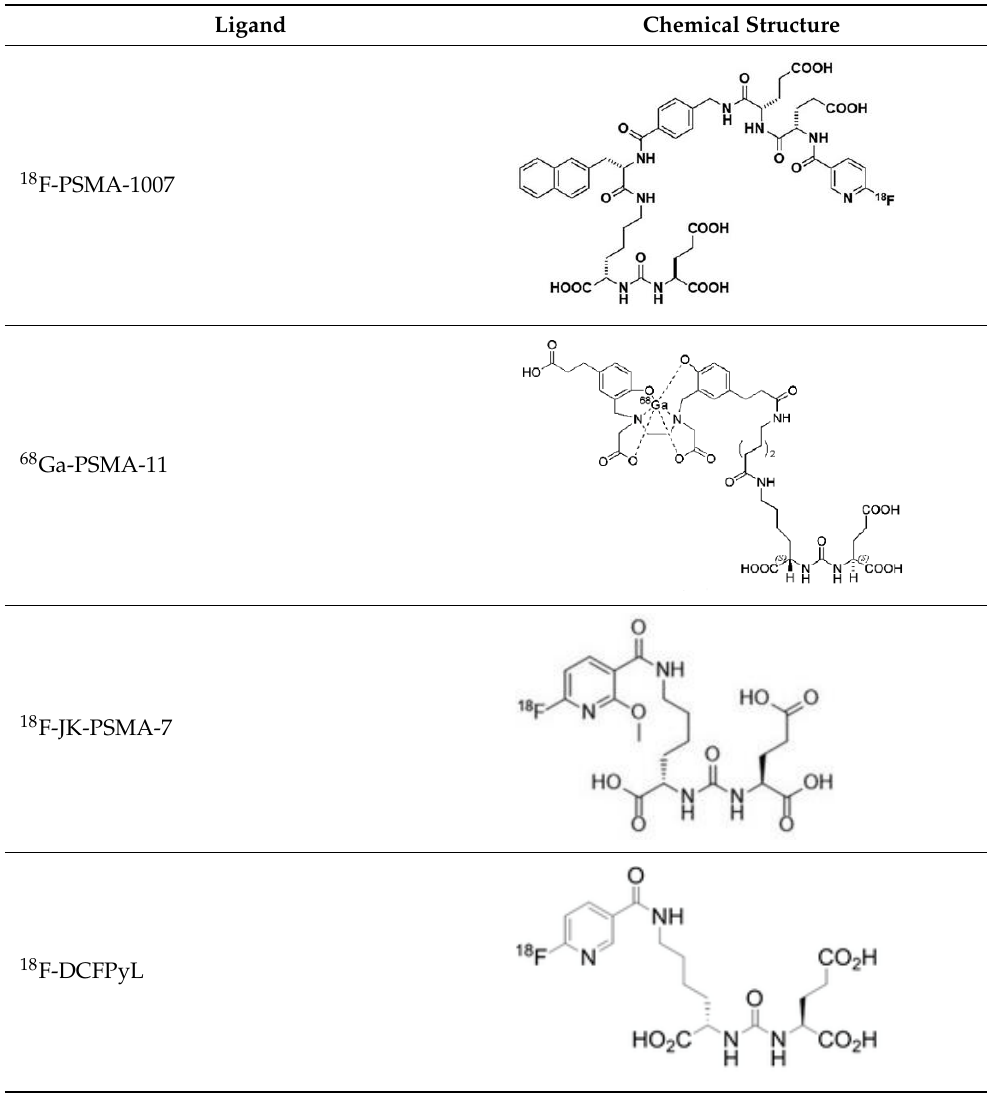
Table 1. Chemical structure of different PSMA ligands.